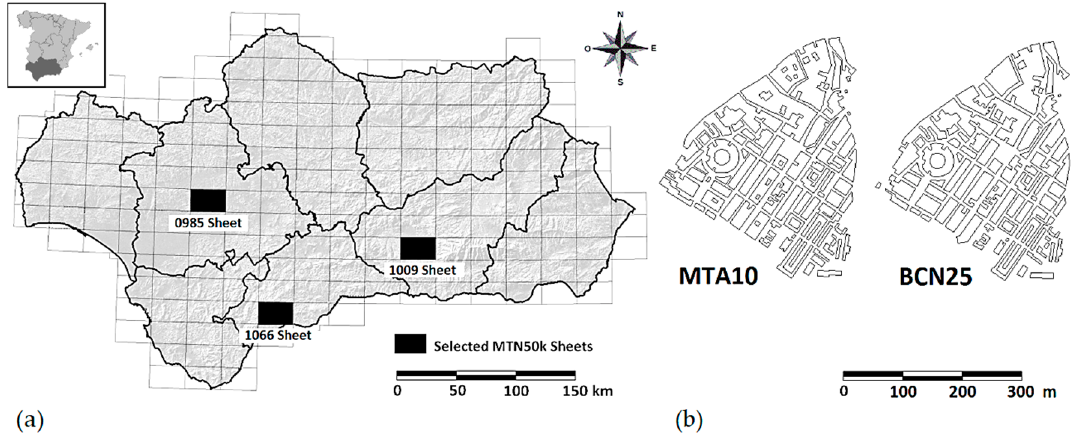
Figure 2. ( a ) Selected sheets of the National Topographic Map E50k of the region of Andalusia (southern Spain) and its administrative boundaries, and ( b ) examples of polygonal features belonging to Mapa Topográfico de Andalucía E10K (MTA10) and Base Cartogra ́ fica Nume ́ rica E25k (BCN25). Source: [1].